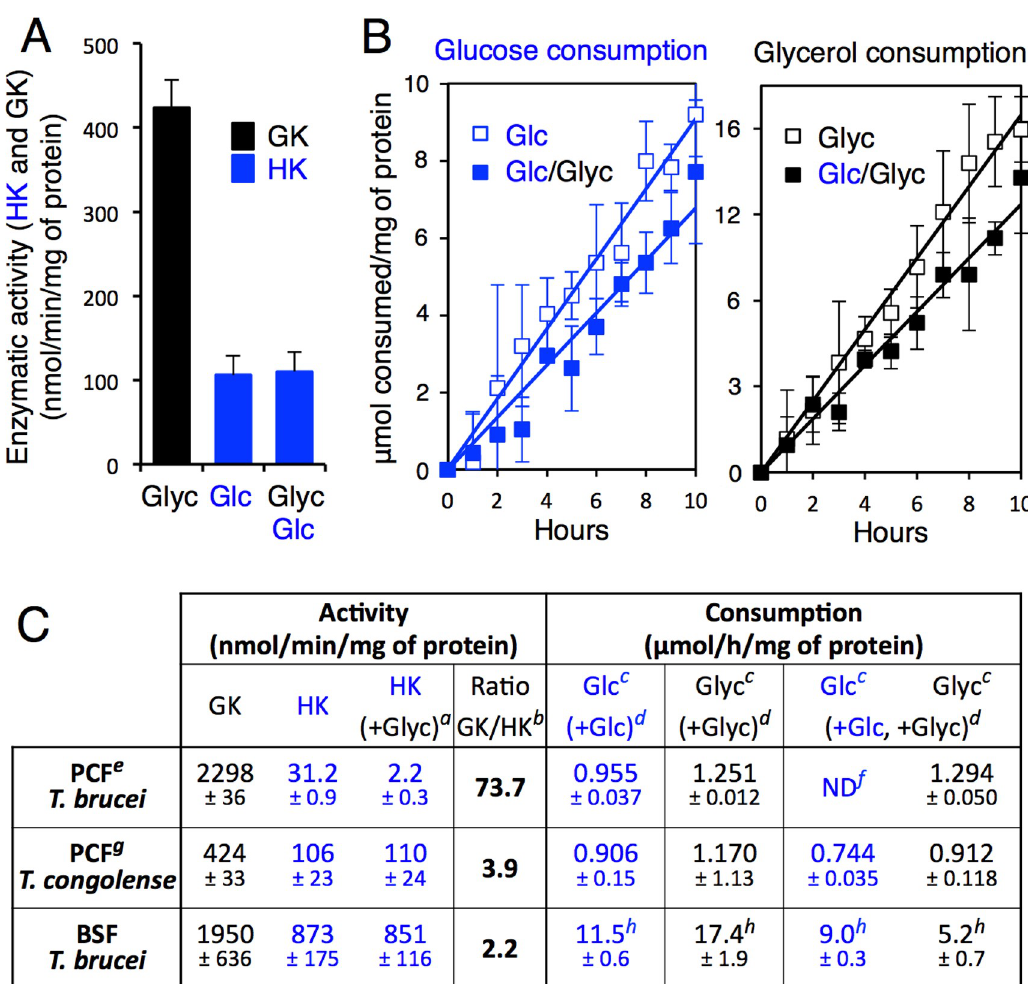
Fig 5. Glycerol metabolism in other trypanosomatids. (A) Glycerol kinase (GK) and hexokinase (HK) activity in total cell extracts of the procyclic form (PCF) of T . congolense in the presence of glucose (Glc), glycerol (Glyc) or equal amounts of glucose and glycerol (Glc/Glyc). (B) Consumption of glucose (left) and glycerol (right) by the T . congolense PCF incubated in glucose-rich (2 mM), glycerol-rich (2 mM) and glucose/glycerol (2 mM each) conditions. (C) Correlation between high GK/HK activity ratio and preference for glycerol over glucose. BSF, bloodstream form. a HK activity in the presence of equimolar amounts of glucose and glycerol. b Ratio between GK and HK activity. c Rate of glucose (Glc) or glycerol (Glyc) consumption. d Culture in the presence of 2 mM glucose (+Glc), 2 mM glycerol (+Glyc) or both (+Glc, +Glyc). e Data from Fig 1. f ND, not detectable. g Data from (B). h Data from [20]. Data supporting the results described in this figure can be found at https://zenodo.org/record/5075637#.